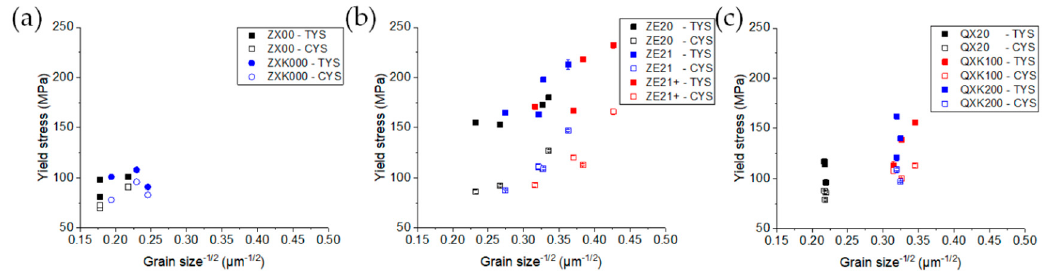
Figure 11. Yield stresses in tension and compression vs. the inverse square root of the grain size (Hall–Petch plot): ( a ) ZX-series alloys, ( b ) ZE-series alloys, and ( c ) QX-series alloys.